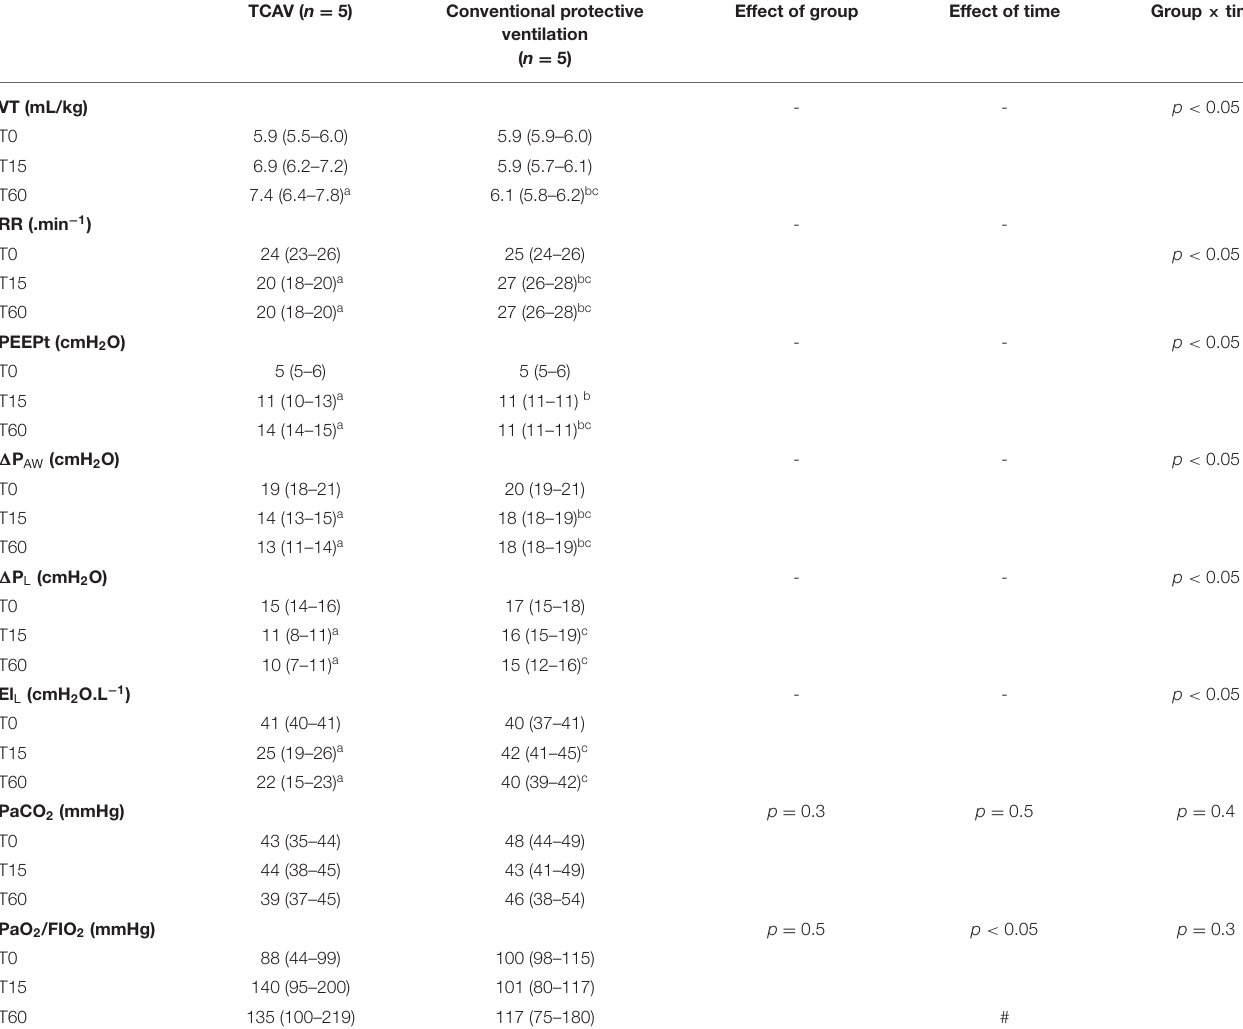
TABLE 2 | Respiratory